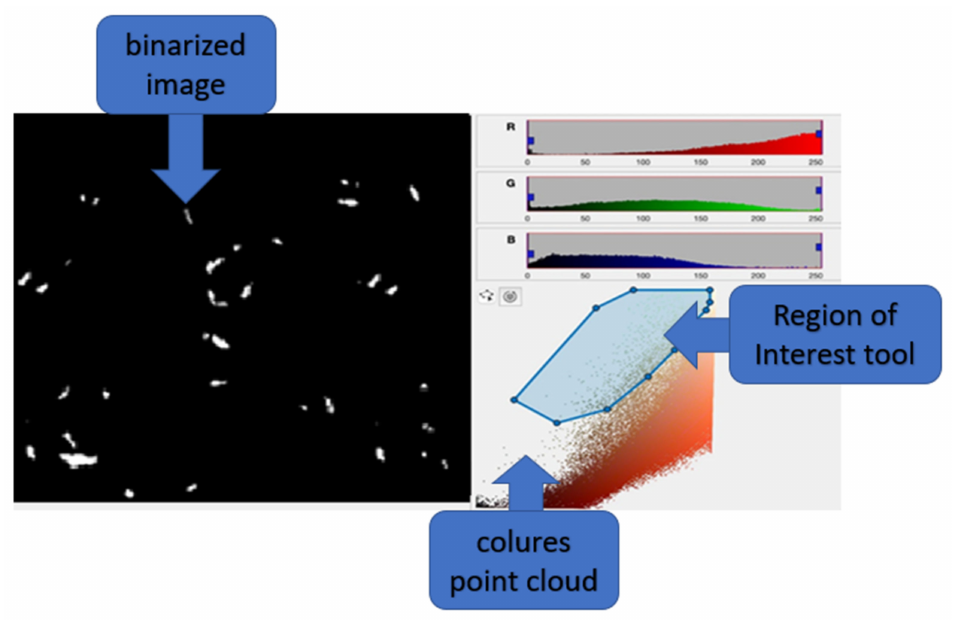
Figure 6. Processing of binarized TMR